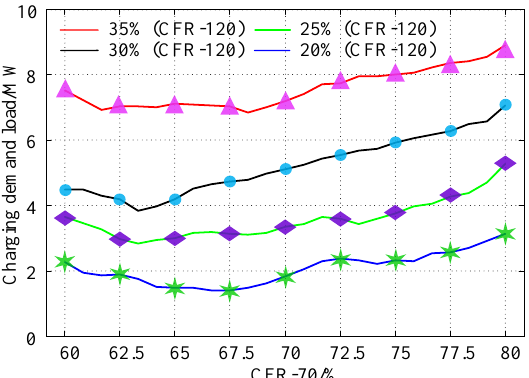
Figure 19. Charging load peak under different groups of Charging Facility Ratio.